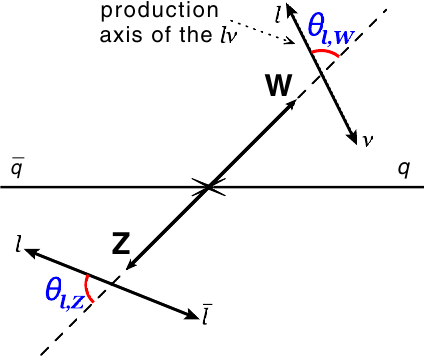
Fig. 7 The decay angle θ (cid:4), W ( Z ) is defined as the angle between the negatively (positively for W + ) charged lepton produced in the decay of the W ( Z ) boson as seen in the W ( Z ) rest frame and the direction of the W ( Z ) which is given in the W Z centre-of-mass